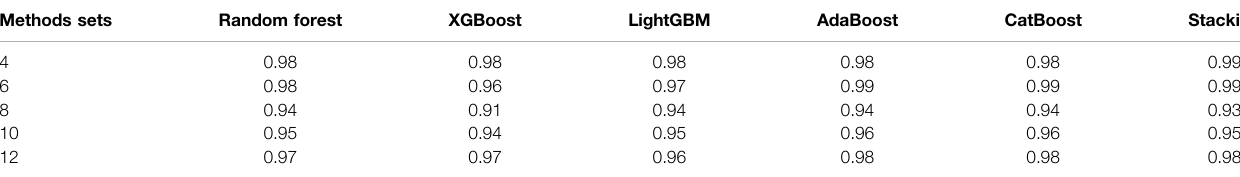
TABLE 2 | The accuracy of different classi fi ers for training sets of 70 curves per generating model. Methods